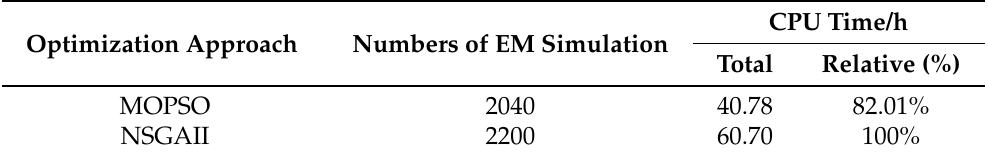
Table 2. Comparison of computational cost. Optimization